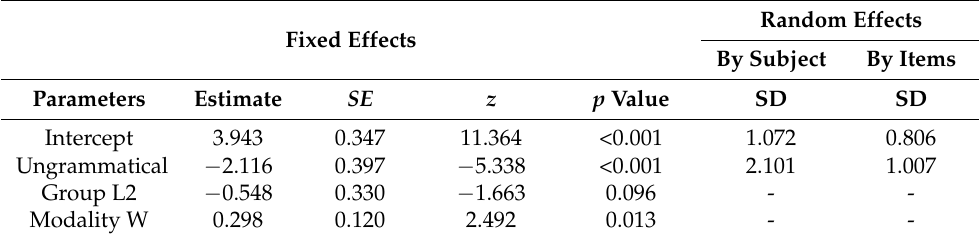
Table 4. Parameter estimates for second language (L2) and heritage language (HL) learners’ accuracy with (un)grammatical